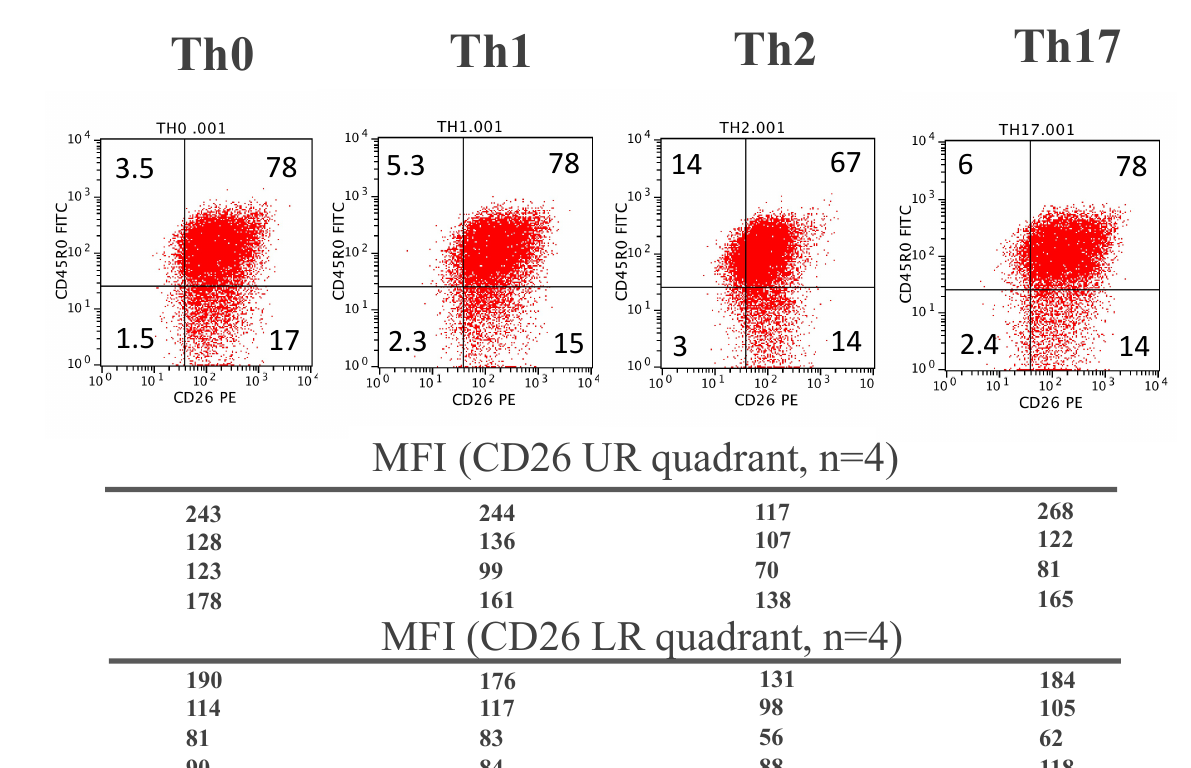
Figure 6: Gated on FSC/SSC and CD3/CD4 double positives in PBMC polarized to: